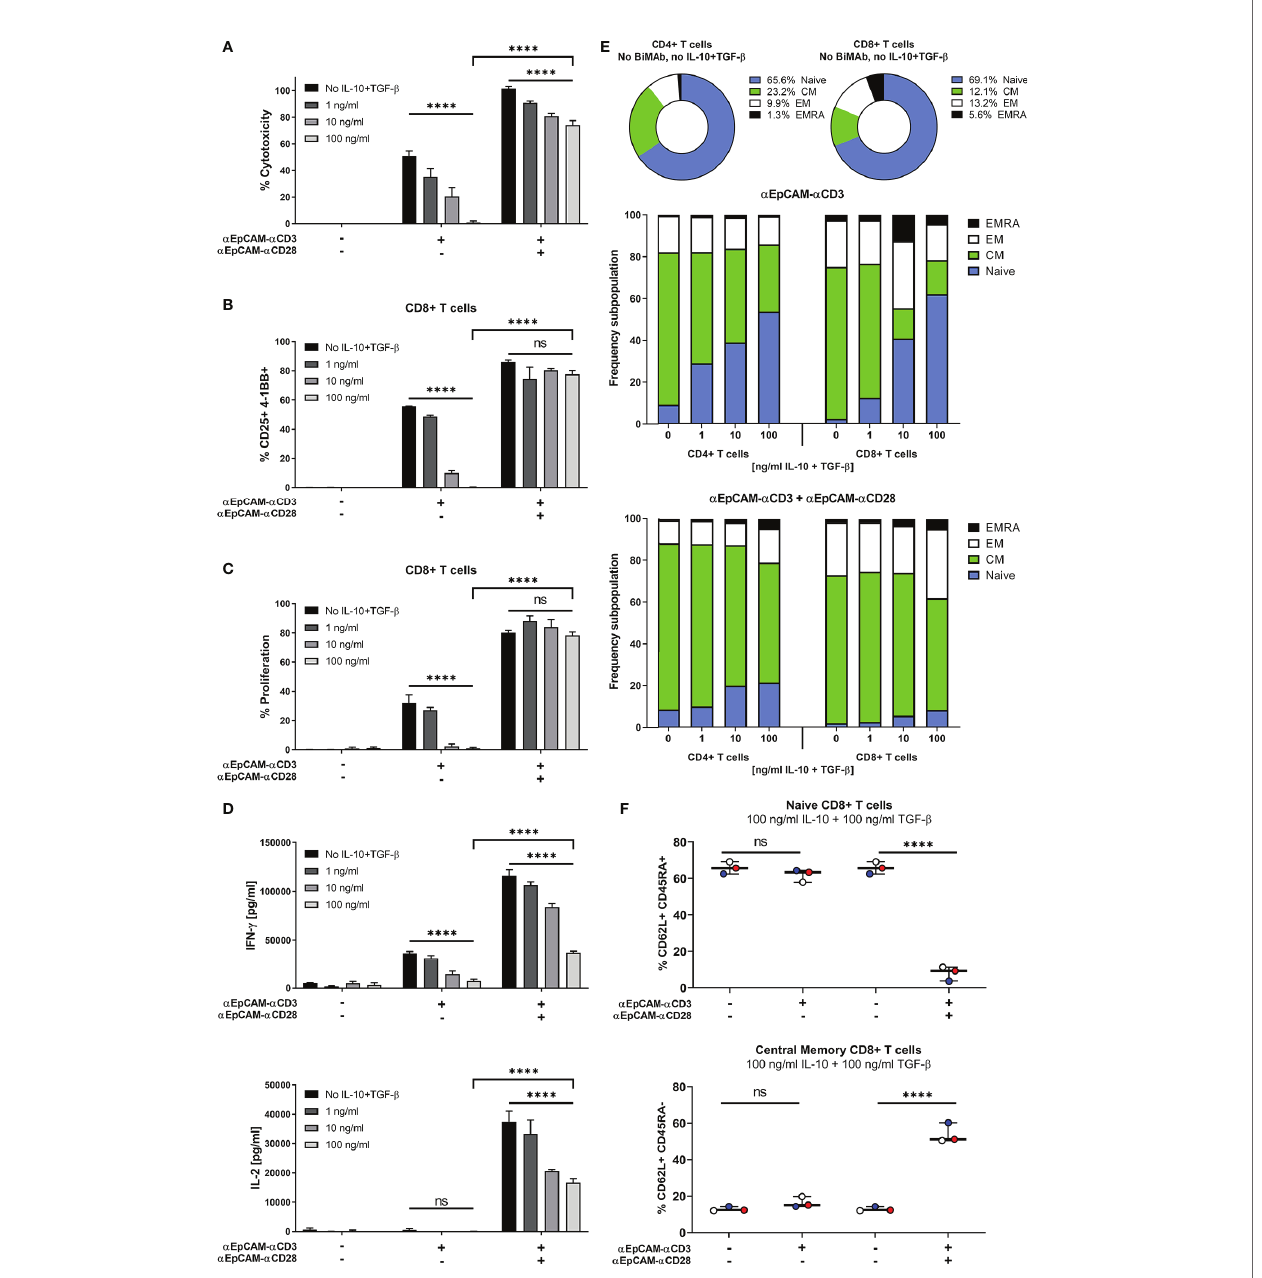
FIGURE 2 | Co-stimulation overrides immunosuppressive effects of exogenous IL-10 and TGF- b . MCF-7 cells were co-cultured with puri fi ed CD3 + T cells and serial dilutions of human IL-10 and TGF- b (0, 1, 10, 100 ng/ml each) in the presence or absence of 1 nM a CD3 +/- a CD28 EpCAM-targeting BiMAb. (A) MCF-7 tumor cell lysis was measured by LDH release assay after 48 h of co-culture. (B) CD8 + T cell activation was determined by fl ow cytometry and shown as percentages of CD25 + /4-1BB + T cells. (C) Frequencies of proliferating CD8 + T cells were measured by fl ow cytometry based on CTV dilution after 5d of incubation. (D) IFN- g (top panel) and IL-2 secretion (bottom panel) by T cells co-cultured with MCF-7 cells and a EpCAM – a CD3 +/- a EpCAM – a CD28 in the presence of the indicated concentrations of IL-10 and TGF- b . (E) Subpopulations of CD4 + and CD8 + T cells were characterized by fl ow cytometry based on CD62L and CD45RA surface expression: Naïve (CD62L + /CD45RA + ), central memory (CM, CD62L + /CD45RA – ), effector memory (EM, CD62L – /CD45RA – ) and effector memory cells re-expressing CD45RA (EMRA, CD62L – /CD45RA + ). Frequencies of subpopulations in untreated controls are shown for CD4 + and CD8 + T cells, respectively (top). Bar diagrams show the effects of BiMAb on CD4 + and CD8 + T cell subpopulations with increasing concentrations of IL-10 and TGF- b (middle and bottom panel). (F) Frequencies of naïve and central memory CD8 + T cells after treatment with 100 ng/ml IL-10, 100 ng/ml TGF- b and a EpCAM – a CD3 +/- a EpCAM – a CD28 (1 nM), or without BiMAb treatment for control, with each individual data point representing the mean value of an individual donor. Data represent mean values ± SEM from 3 independent experiments each done in duplicates that were statistically analyzed by two-way ANOVA followed by Tukey ’ s multiple comparison test (A – D) or one- way ANOVA with Dunnett ’ s follow-up test for comparison with no compound control (F) , ns, not signi fi cant; **** p <